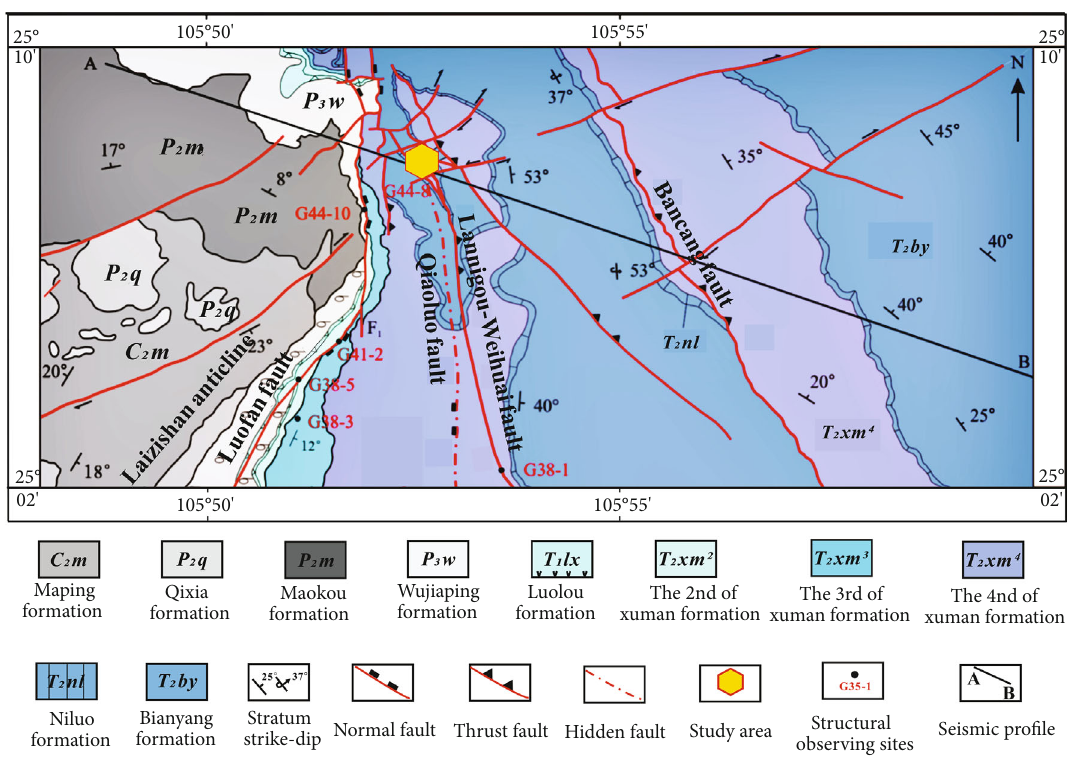
Figure 1: Regional structural geological map [23].